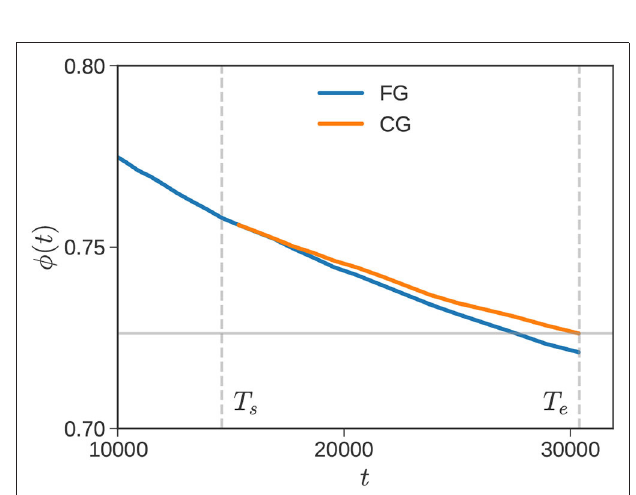
FIGURE 2 | Recalibration. Vertical dashed lines mark T s and T e for an equimolar mixture of ( ¯ Z 1 , ¯ Z 2 ) = (10,100), where dynamics are propagated using a fine-grained (blue) and coarse-grained (orange) time-step. The horizontal line marks φ cg ( T e ), which is used to find the RC scaling factor f rc